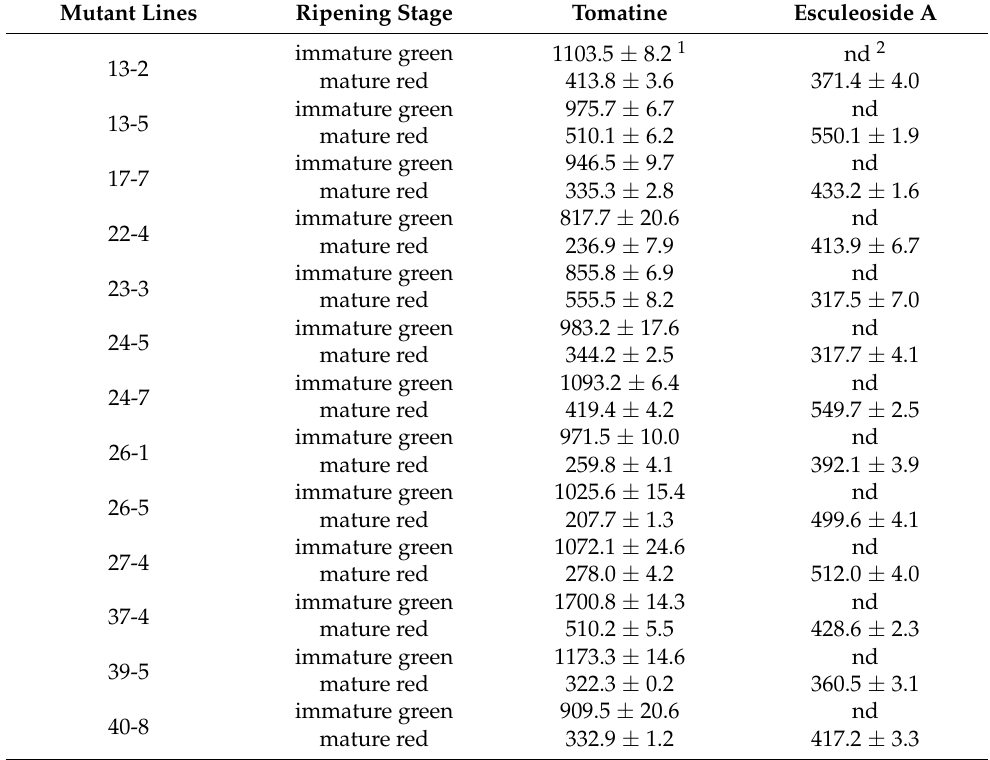
Table 4. Content of two triterpenoid glycosides ( µ g/g of fresh weight) in the mutant lines with tomatine content at the ripening